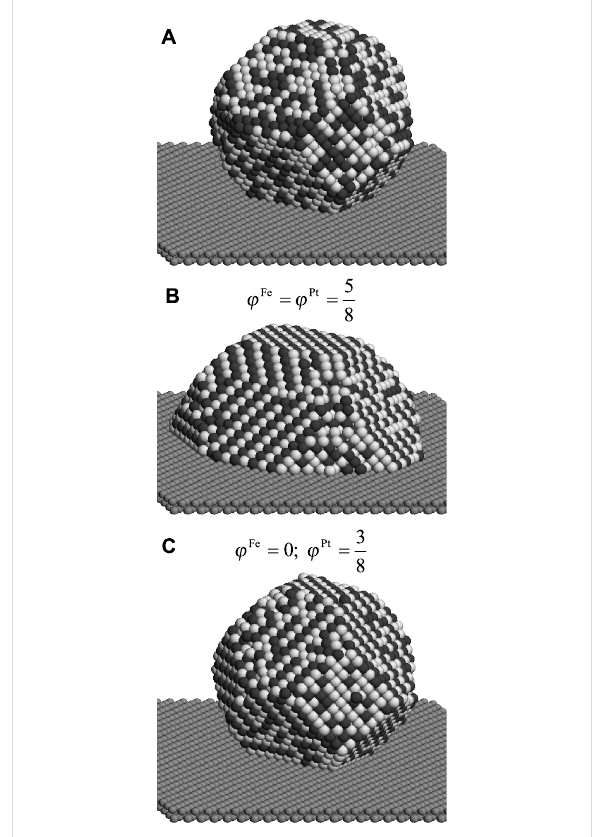
Figure 4: Snapshots of supported FePt nanoparticles illustrating the different interface energetics investigated by the Monte-Carlo simula- tions. A) A disordered particle of Wulff shape with D = 5 nm used at input structure in all simulations. B) Outcome of a simulation with iden- tical Fe-substrate and Pt-substrate interactions leading to strong wetting. C) Outcome of a simulation with only Pt-substrate interactions. The temperature is 1000